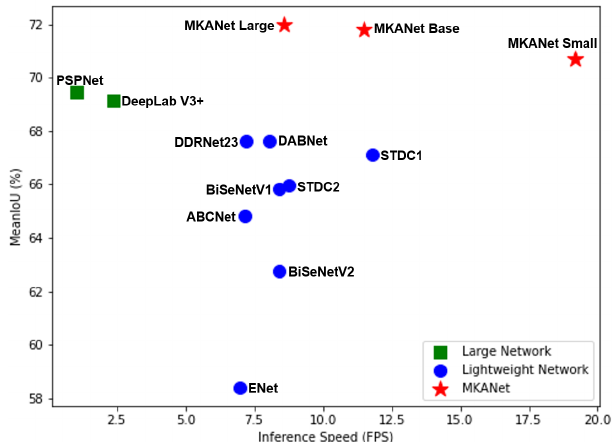
Figure 2. Speed–Accuracy performance comparison on the DeepGlobe Land Cover dataset of image size 2448 × 2448 pixels, where the proposed MKANets achieve state-of-the-art speed–accuracy